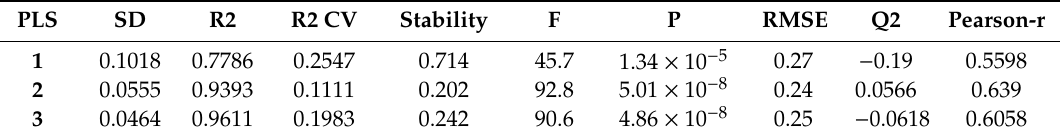
Table 2. PLS statistical parameters of the model AADRRR_2.